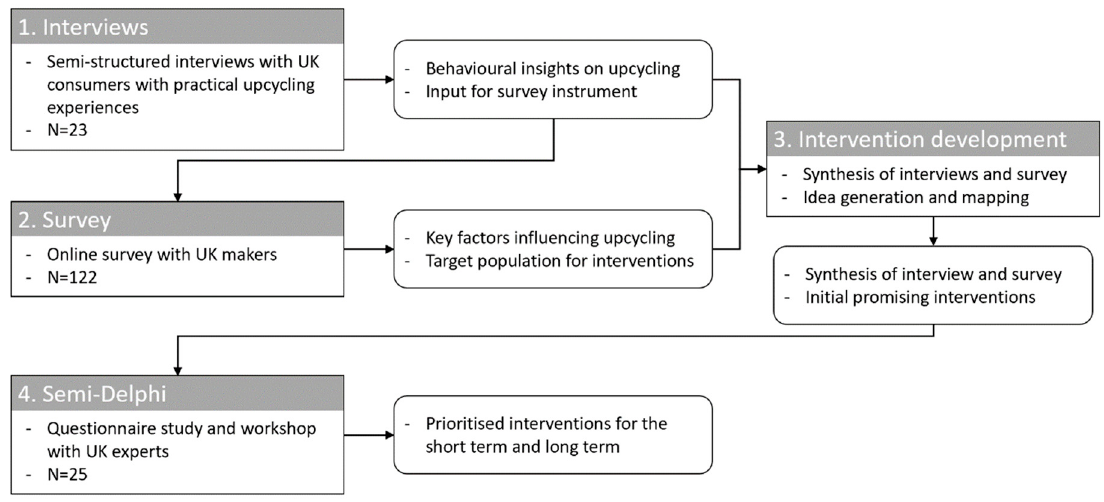
Figure 2. Stages in the methodology employed in this study.